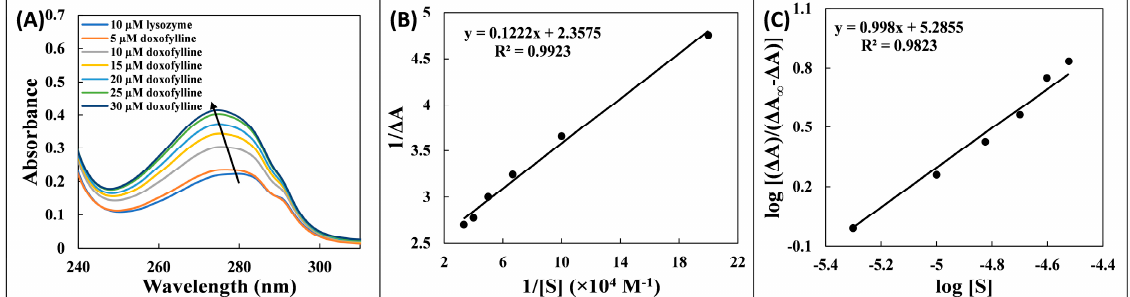
Table 1. Binding parameters for the interaction of doxofylline with lysozyme at 298 K obtained from UV–vis spectroscopy.